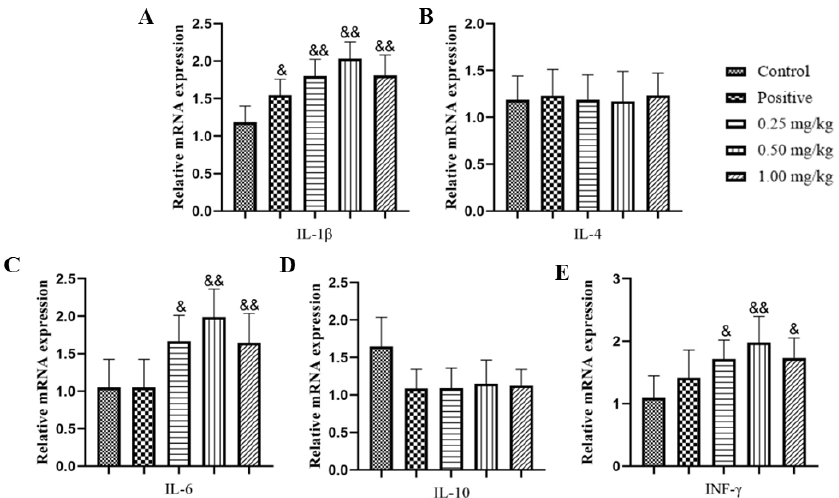
24.64 ± 2.03 b The table is represented as means value ± standard deviation (SD). Values in the same row with different superscripts a–d are statistically different (n = 5, p < 0.05 or p < 0.01). 2.4. Effect of Glycine Nano-Selenium on mRNA Expressions of Inflammatory Cytokines in Liver, Lungs, and Spleen of Mice Immunized with H9N2 Avian Influenza Virus Vaccine